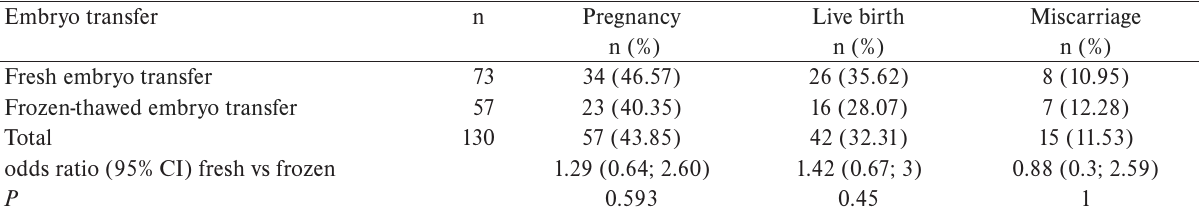
Odds Ration and 95% confidence interval is estimated. Table 2. Distribution of the ET+KET, pregnancy, delivery and abortion grouped based on the diagnose. Medical indications for GS